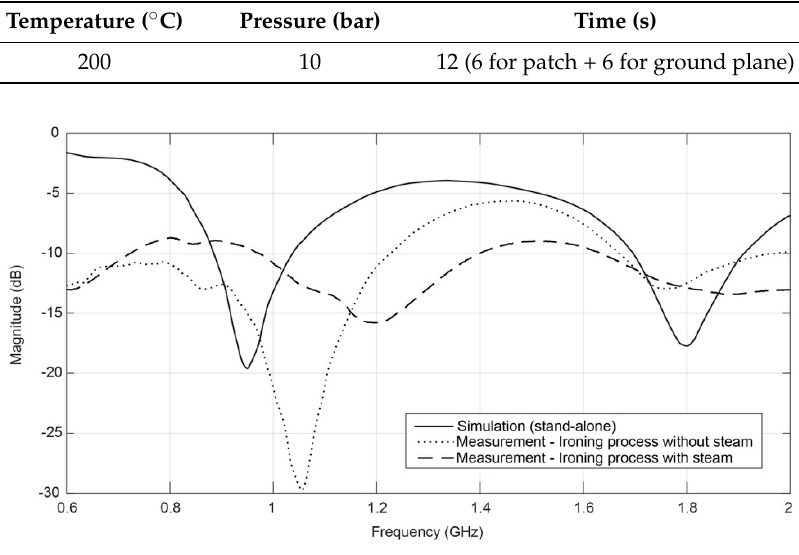
Figure 2. Comparison between ironing processes with, and without, steam.